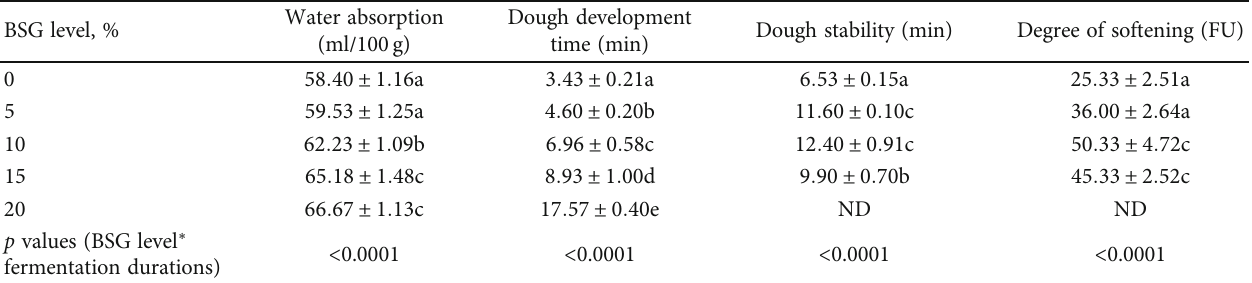
Table 2: Farinograph properties (water absorption, dough development time, dough stability, degree of softening) of dough prepared from the blend of wheat and BSG fl ours.